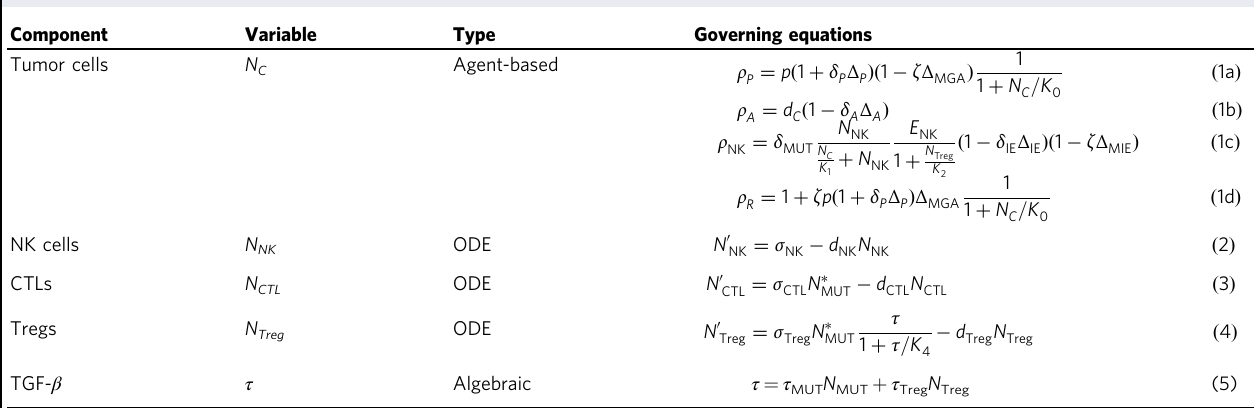
Table 1 Description of the